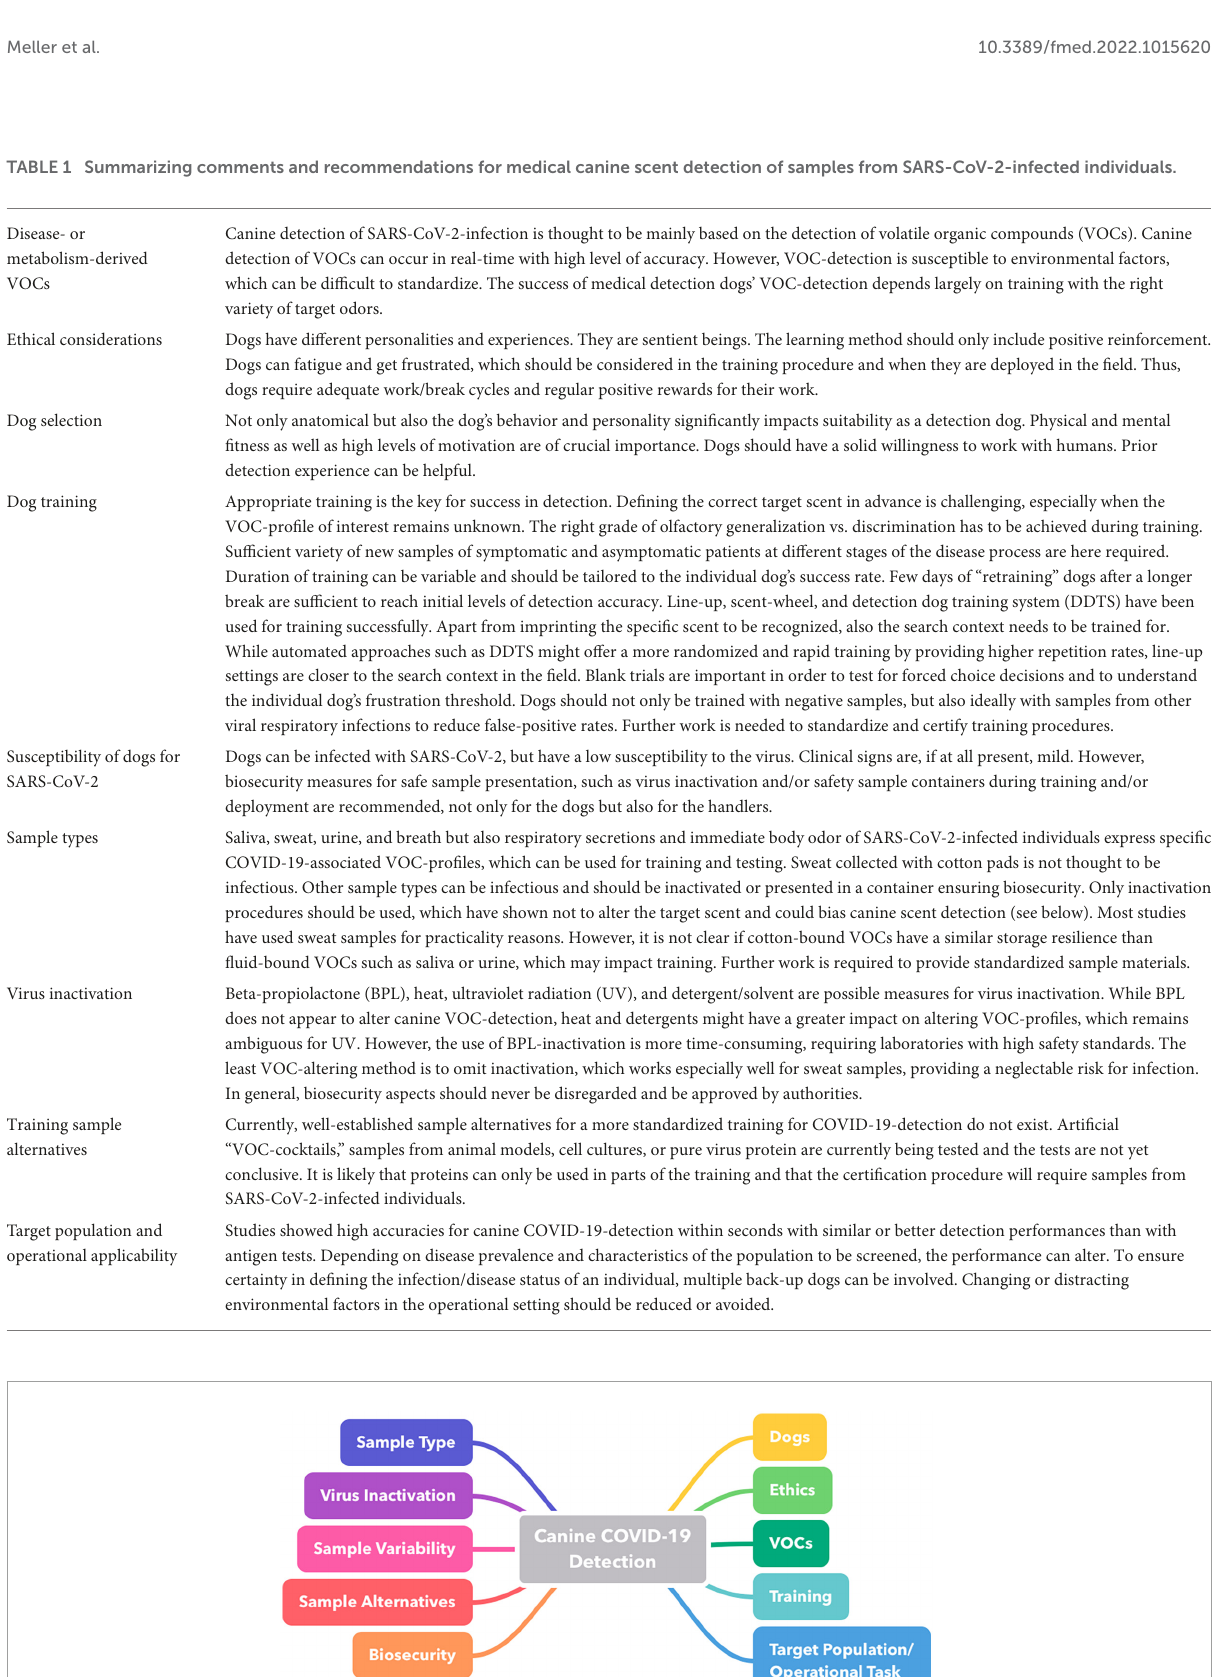
TABLE 1 Summarizing comments and recommendations for medical canine scent detection of samples from SARS-CoV-2-infected individuals.